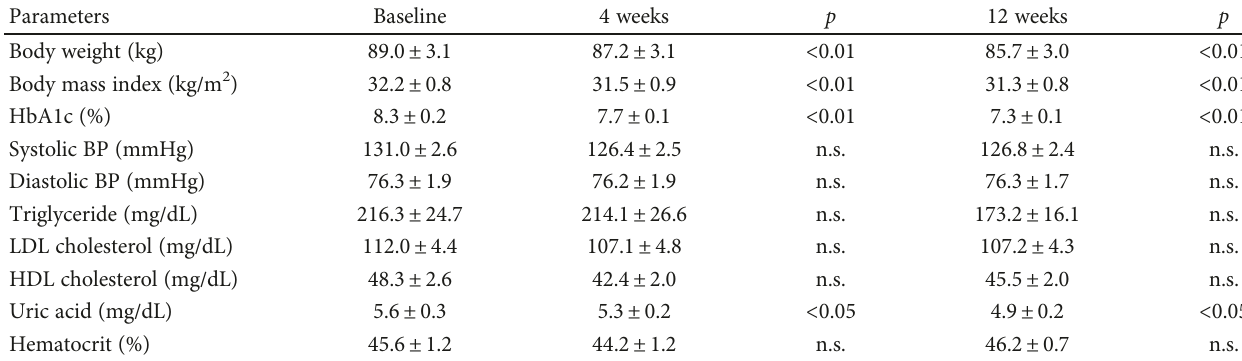
Table 1: E ffi cacy of tofogli fl ozin on various metabolic